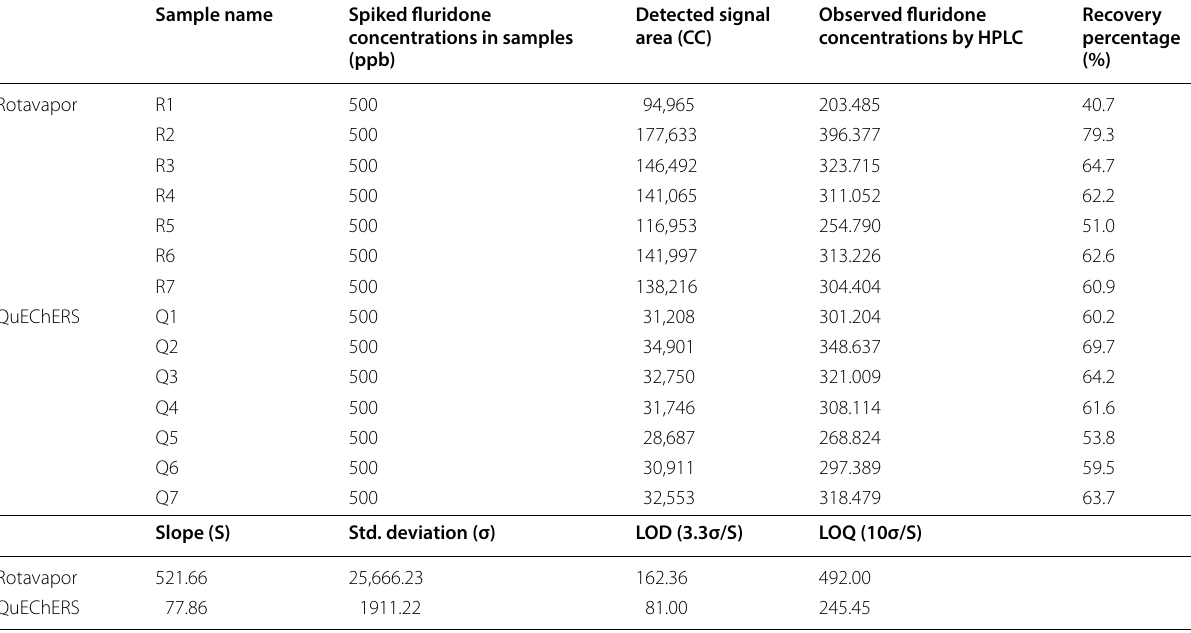
Table 2 Recovery of fluridone, limit of quantification, and limit of detection on rotavapor and QuEChERS based